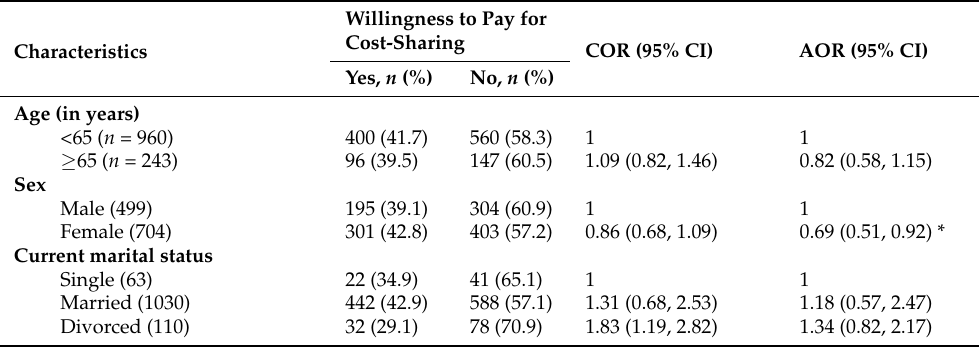
Table 4. Bivariable logistic regression of factors associated with willingness to pay for cost-sharing under National Health